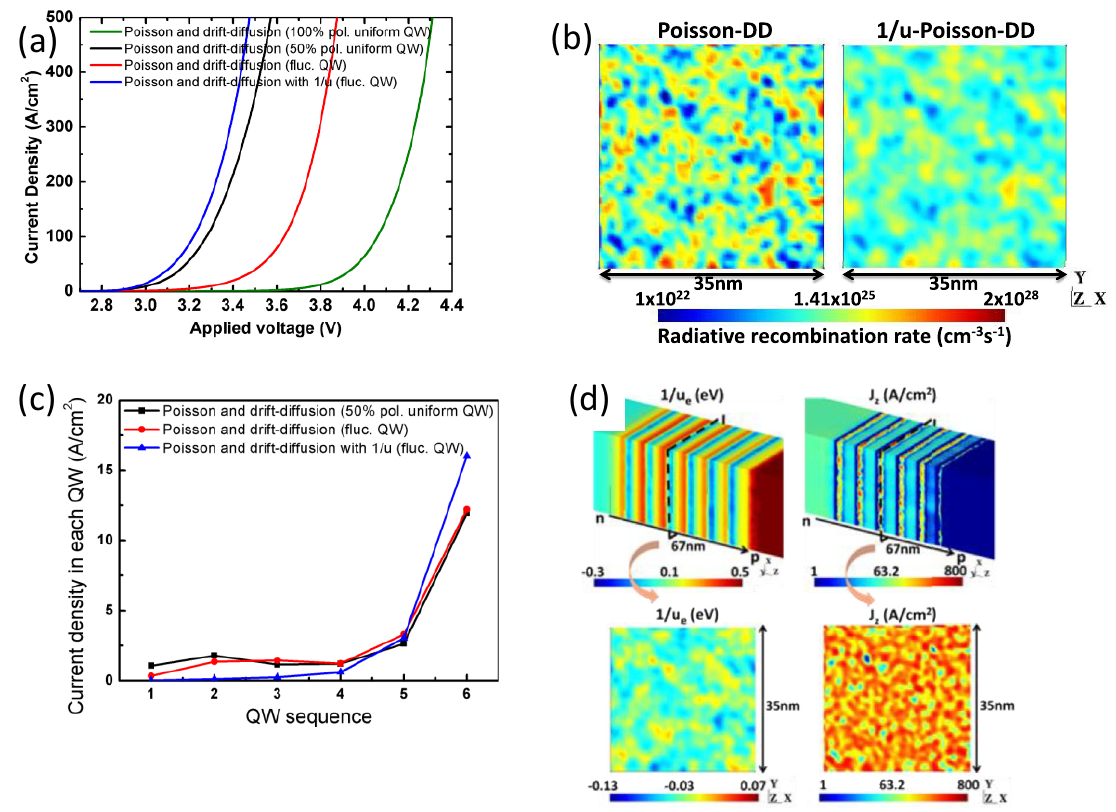
Figure 9: Computations of the six QW LED of Figure 2a. (a) Computed I – V curves: dashed black curve: classical Poisson-DD equations assuming full polarization in the LED structure; red curve: Poisson-DD equationswith classicaltreatmentof disorder(meaningoneuses inthe DDequationsthe computeddisordered potentialdirectly obtained from compositional fl uctuations without computing the quantum corrections by solving the Schrödinger equation of carriers in the disordered potential); full black curve: no disorder, classical Poisson-DD equations assuming 50% polarization; blue curve: LL theory